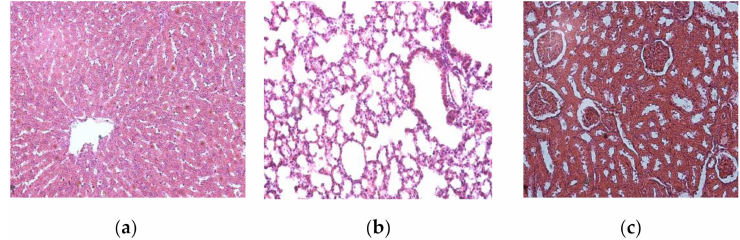
Figure 4. Morphology of the investigated organs for the control group: ( a ) liver normal morphology, col.HE, x20; ( b ) lung normal morphology, col.HE, x20; ( c ) kidney normal morphology, col.HE, x20.